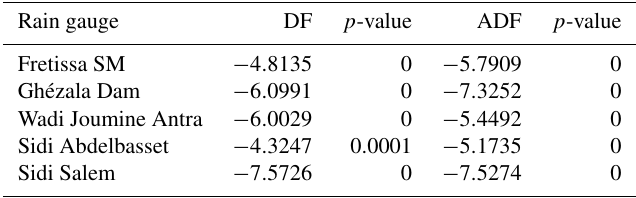
Table 5. The Dickey–Fuller test and the Dickey–Fuller augmented test (ADF). Rain gauge